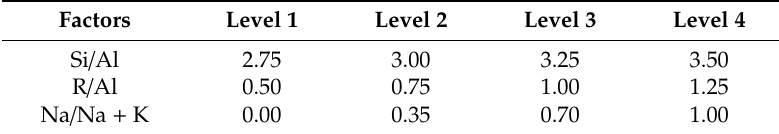
Table 3. Selected factors and their variation range.